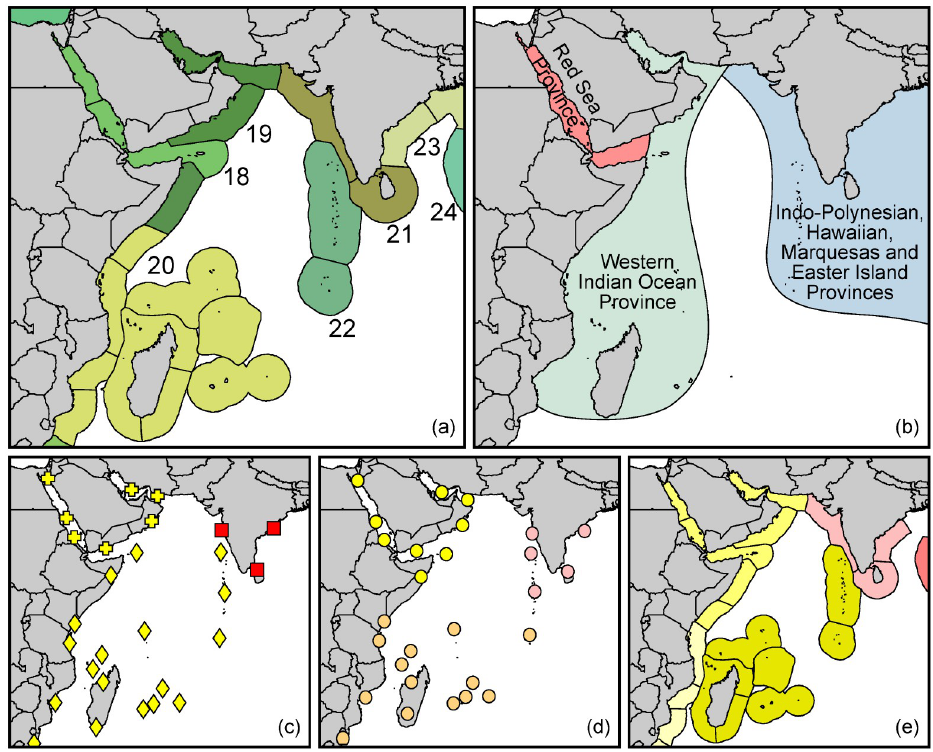
Fig 1. North-western Indian Ocean sections of three current global marine “biogeographic” classification schemes: (a) ‘Marine Ecoregions’ (Spalding et al. 2007), (b) ‘Marine/Fish Biogeography’ (Briggs and Bowen 2012), (c-e) ‘Global Reef Fish Biogeography’ (Kulbicki et al. 2013, with three alternatives); as evaluated in the present article. (a-e: Baseline map sourced 2019 from Natural Earth, free vector and raster map data < naturalearthdata.com > with no copyright restrictions. a, e: Ecoregion boundaries redrawn from GIS data accompanying Spalding et al. (2007), sourced 2012 from < conserveonline.org > , with free permission for scientific use and reproduction (to date only available from < worldwildlife.org > ), colours modified.b-d: Redrawn manually by the authors according to the original publications, colours modified).